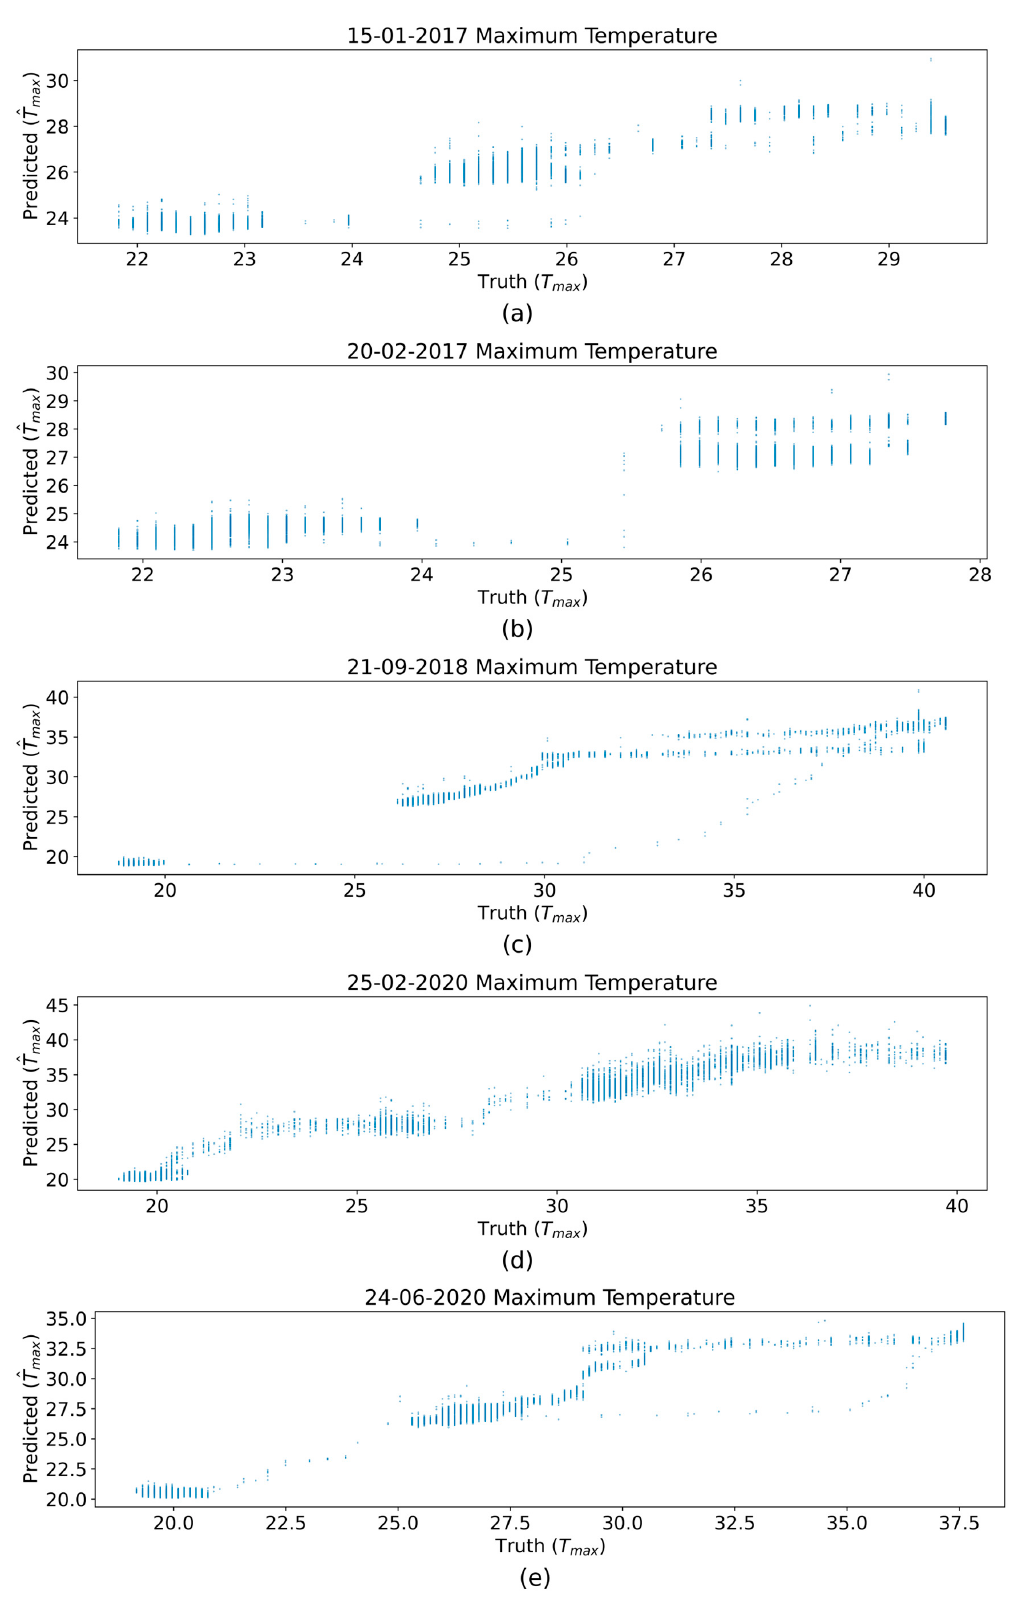
Figure 7. Same as Figure 6 except for scatterplots with the correlation between T max and T ̂ max for five test cases: ( a ) 2017-01-15, ( b ) 2017-02-20, ( c ) 2018-09-21, ( d ) 2020-02-25, and ( e ) 2020-06-24.